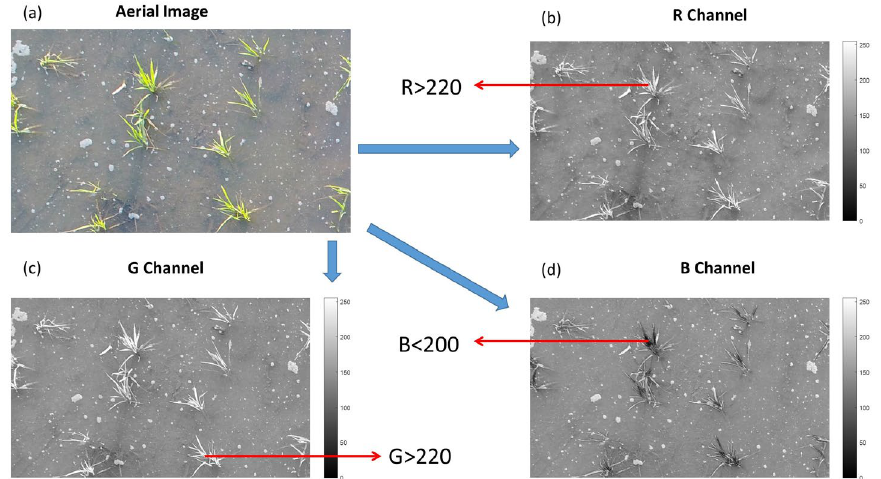
Figure 1. RGB color characteristics of the seedlings.